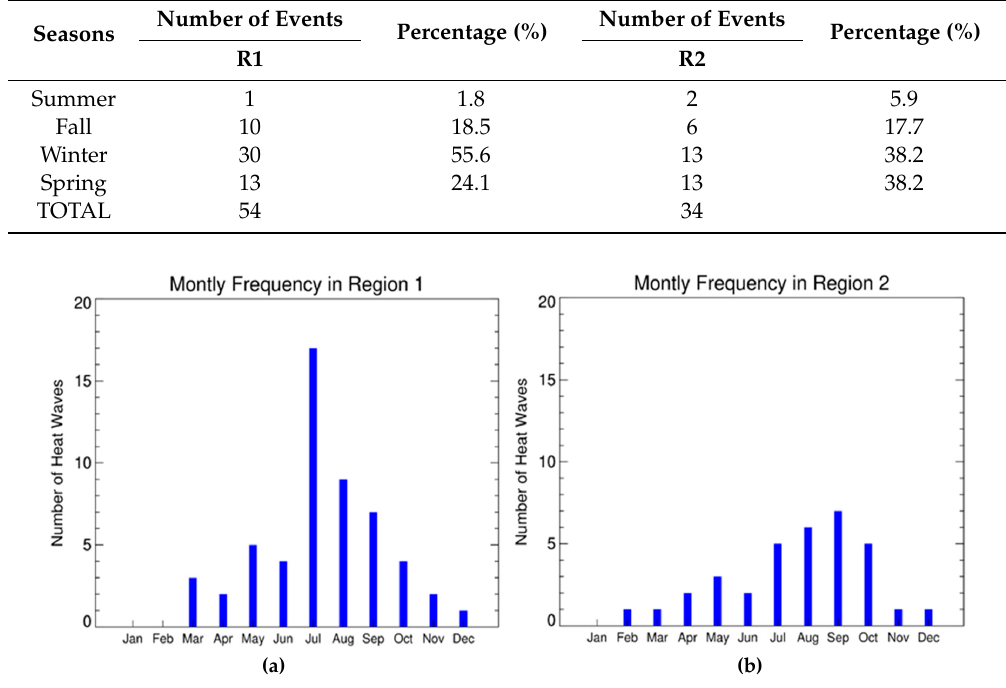
Figure 5. Number of heat waves per month from 1980 to 2013 in regions ( a ) 1 and ( b ) 2.